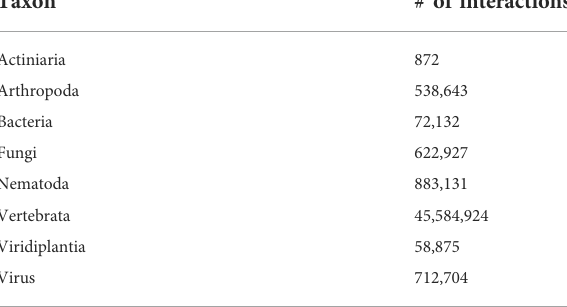
TABLE 3 Number of interactions in the 8 taxa in the RNAInter database. An overview of the main publicly available datasets for RNA-protein interaction prediction is given in Table